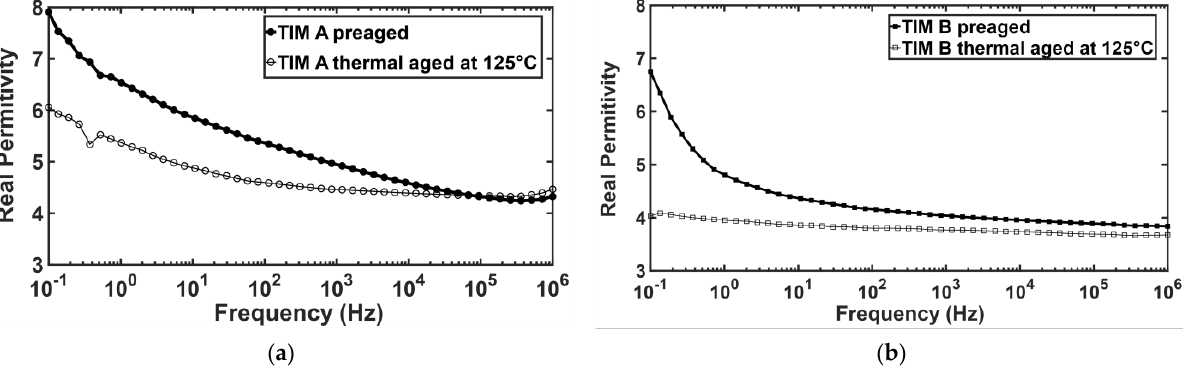
Figure 18. Real permittivity of TM A and TIM B.